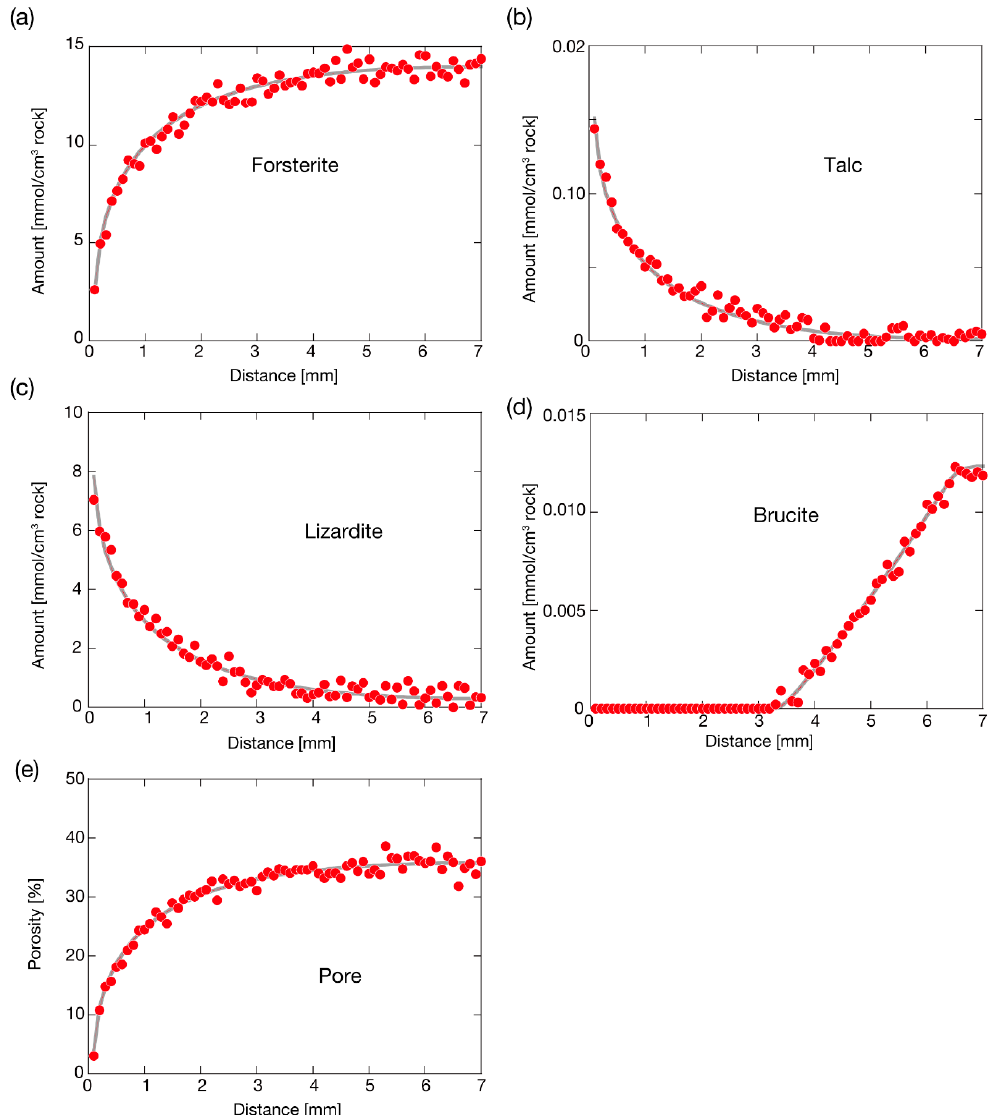
Figure 3. Synthetic datasets with a noise level of σ y = 10 –1.5 used in the accuracy tests. ( a – e ) Plots with gray lines show true values predicted using the reactive transport model (Equation (9), with the parameters given in Section 3) for ( a ) forsterite, ( b ) talc, ( c ) lizardite, ( d ) brucite, and ( e ) pores. Red data points are synthetic noisy data.